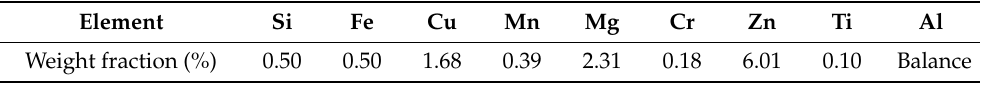
Table 1. Chemical composition (wt.%) of